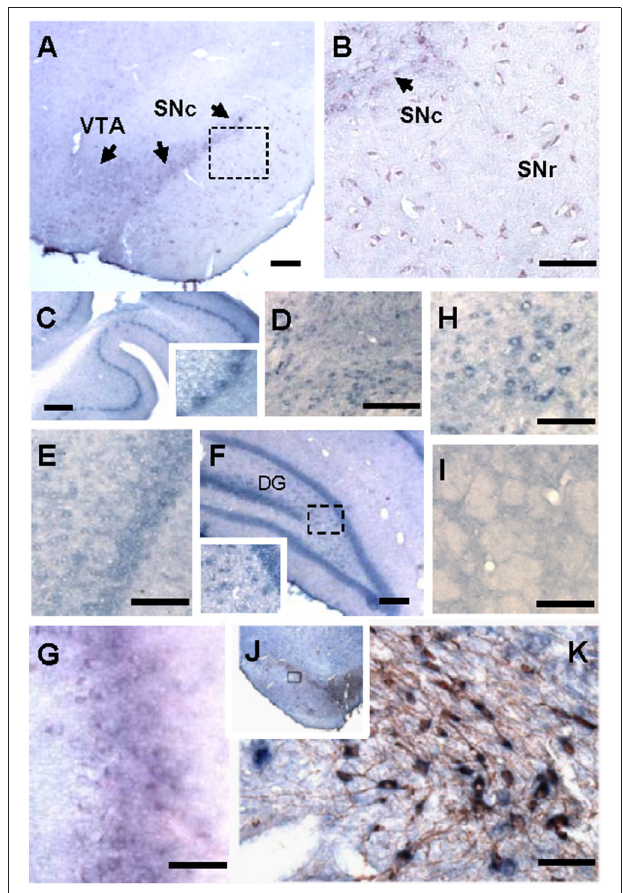
FIGURE 1 | Hapln2 is highly expressed in various brain regions including the substantia nigra of adult rat brain. Panels (A–H) show that the Hapln2 hybridization signals are detected in various rat brain regions including the substantia nigra (A,B) and ventral tagmental area (A) , cerebellum (C) , brain stem (D) , cerebral cortex (E) , hippocampus (F) , olfactory bulb (G) , and red nucleus (H) . (I) Lower Hapln2 hybridization signals are seen in the striatum. (J) Representative photomicrographs showing robust Hapln2 hybridization signals in TH-positive neurons in the substantia nigra (SN). Panel (K) shows the enlarged images of the squared areas in J. Arrows indicate the Hapln2 hybridization signals in the VTA and SNc (A,B) . SNc, substantia nigra pars compacta; SNr, substantia nigra pars reticulata. Scale bars = 300 µ m.